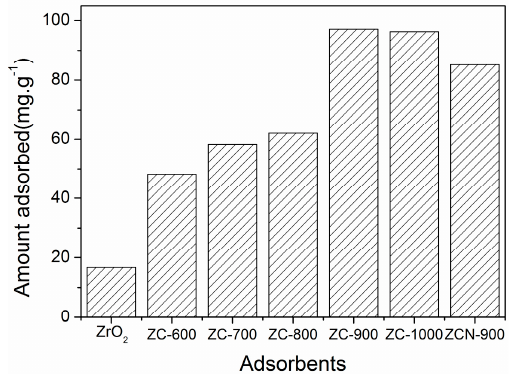
Figure 5. Adsorption of CV on different adsorbents. Initial CV concentration = 25.1 mg·L − 1 , 24 h reaction time.